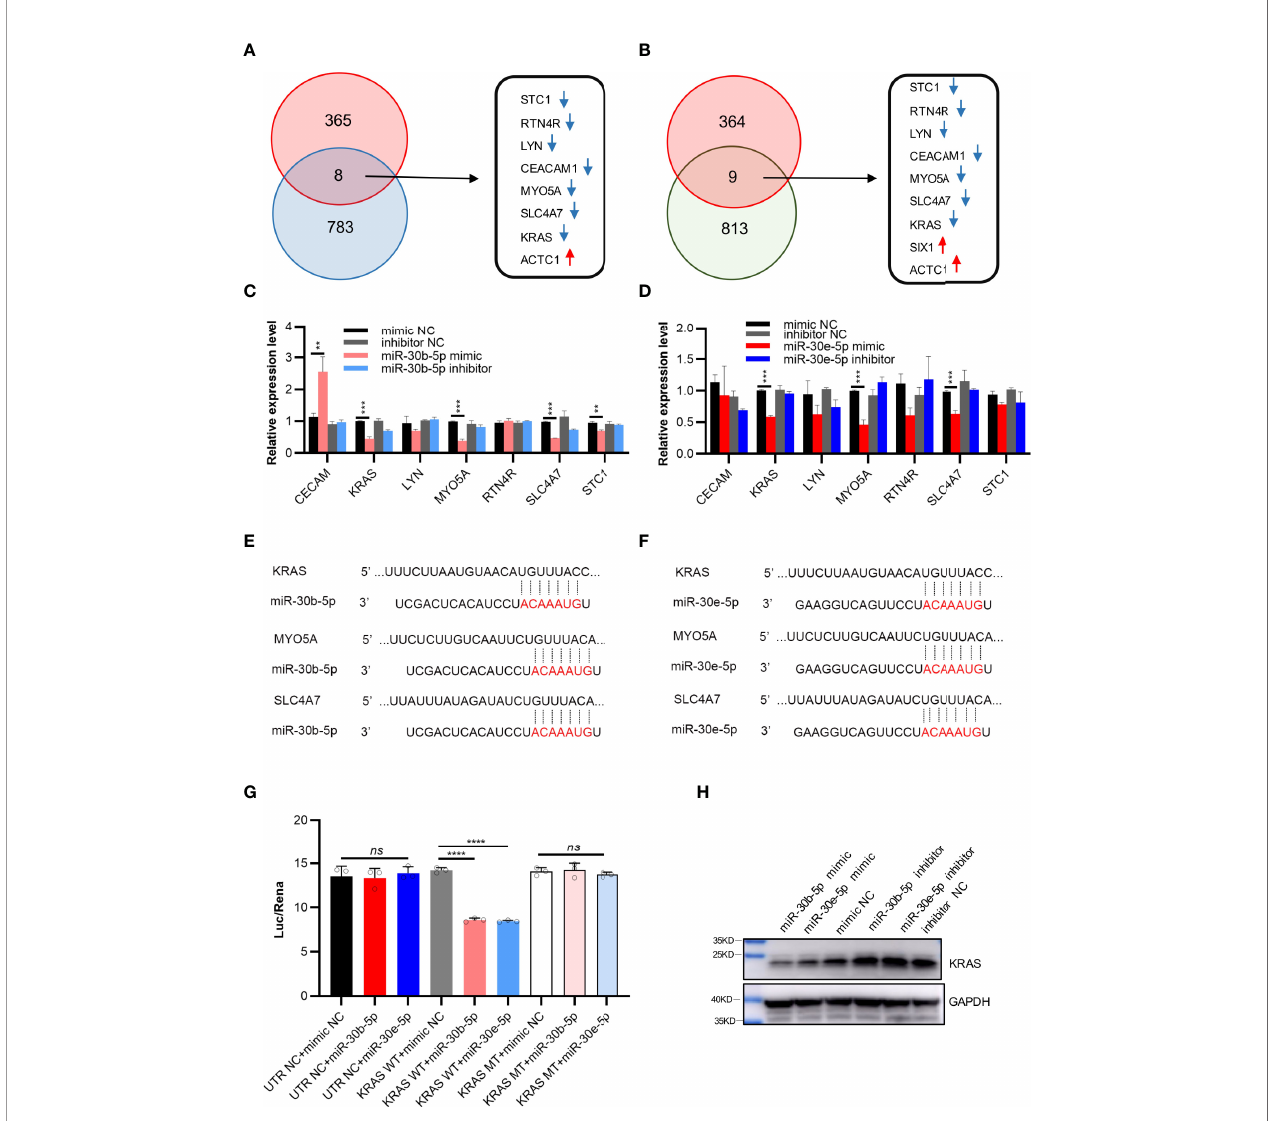
FIGURE 5 | Possible target genes of miR-30b-5p or miR-30e-5p in HNSCC. (A) The intersection of differential genes in mRNA microarray (373) and predicted targeted genes of miR-30b-5p by ENCORI (791). There were 8 genes in the intersection, the red arrows representing up-regulated genes and the blue arrows representing down-regulated genes. (B) The intersection of differential genes in mRNA microarray (373) and predicted potential targeted genes of miR-30e-5p by ENCORI (822). There were 9 genes in the intersection, the red arrows representing up-regulated genes and the blue arrows representing down-regulated genes. (C) The relative expression level of possible target genes in transfected SCC9 with miR-30b-5p mimic or inhibitor. (D) The relative expression level of target genes in transfected SCC9 with miR-30e-5p mimic or inhibitor. (E, F) Base pairing of miR-30b-5p or miR-30e-5p with 3 ’ UTR of target mRNAs was predicted by TargetScan (http://www.targetscan.org/vert_72/). (G) Relative luciferase activity after cotransfection of 293T cells with miR-30b-5p or miR-30e-5p and vectors containing wilt- type KRAS 3 ’ -UTR or 3 ’ -mutant KRAS UTR cloned behind a Renilla luciferase reportor gene. (H) The expression of KRAS protein after transfection with miR-30b-5p or miR-30e-5p mimic or inhibitor. (** p <0.01, *** p <0.001, **** p <0.0001, n.s., no signi fi